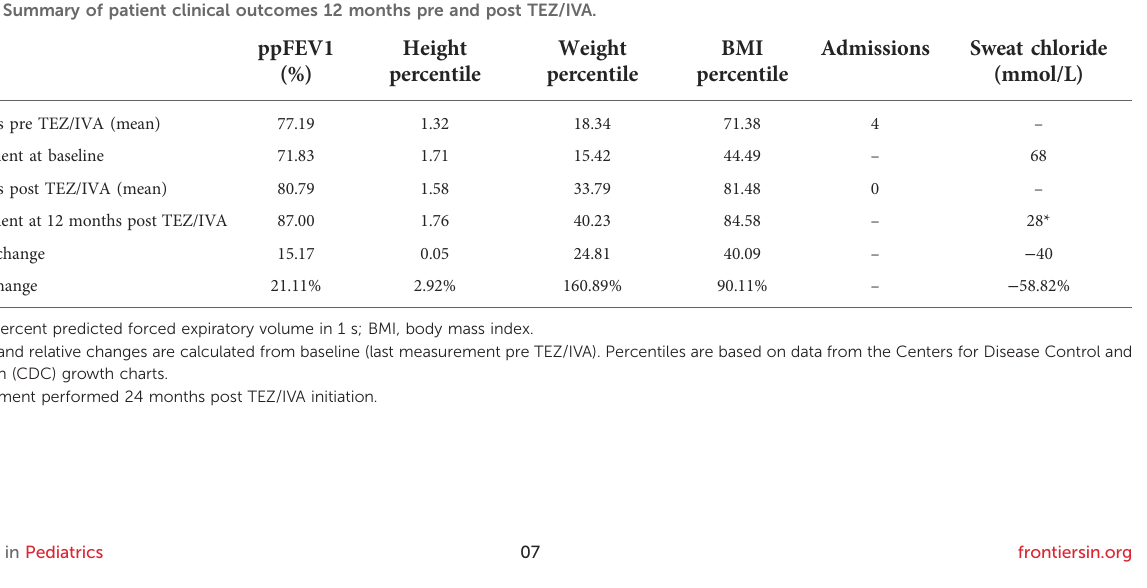
TABLE 1 Summary of patient clinical outcomes 12 months pre and post